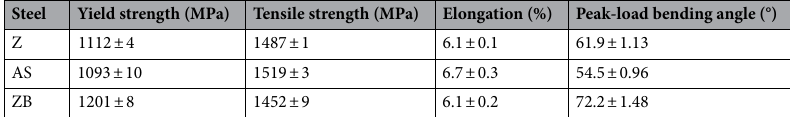
Table 2. Room-temperature tensile and bending test results of the Z, AS, and ZB steels.